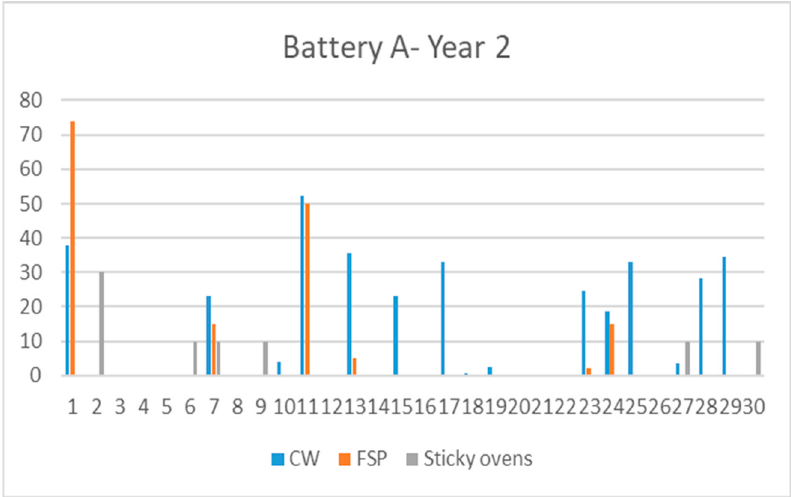
Figure 13. Sticky ovens and refractory repairs battery A, year 2.